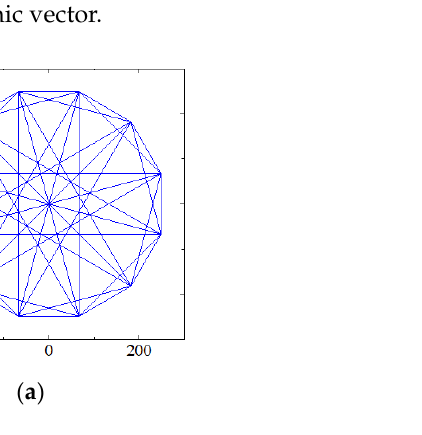
Figure 16. Space voltage vector simulation diagram. ( a ) Traditional DTC space voltage vector simulation diagram. ( b ) Low − harmonic DTC space voltage vector simulation diagram. The six − phase current simulation of the DTP −SynRM’s DTC system is depicted in Figure 17. After adopting a low − harmonic vector, the current becomes closer to the sine wave.